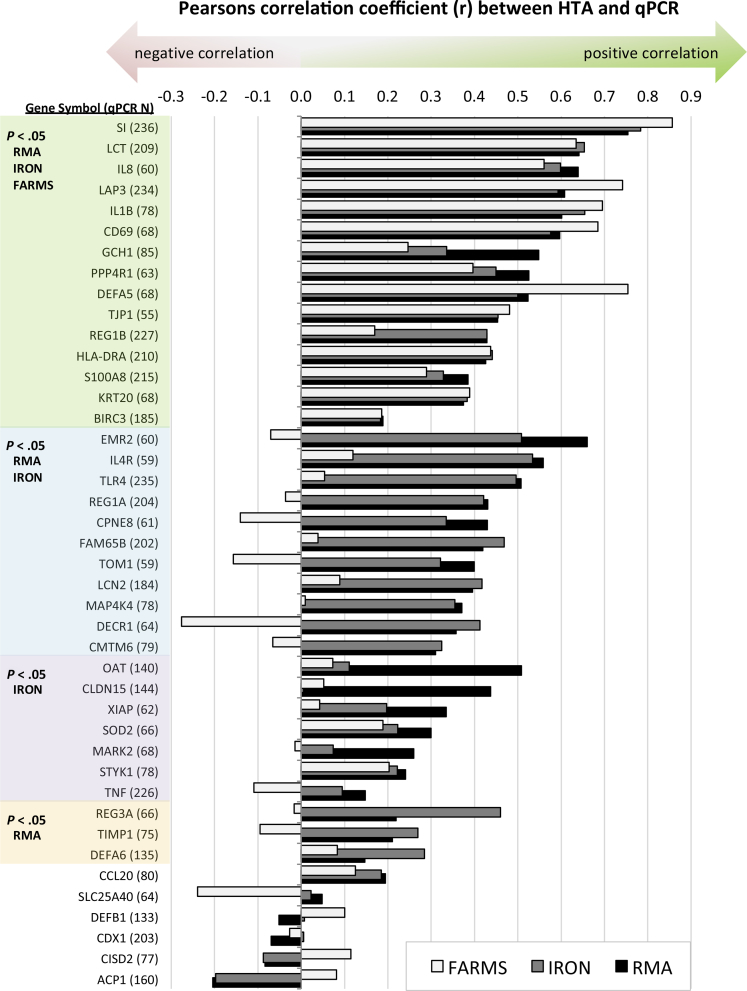
Correlation between qPCR data and the normalized microarray signals RMA and IRON. Of the 42 transcripts that were assessed by both microarray and PCR, significant correlations were found in 36 of them by one or more normalization methods. The transcripts were not chosen simply for their association with EED, because some were not associated, but to assess the accuracy of the microarray across the spectrum of protein coding genes.